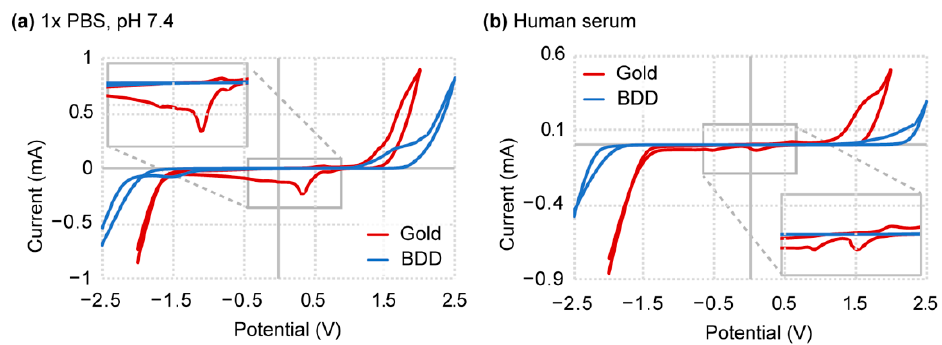
Figure 2. Cyclic voltammetry of boron-doped diamond (BDD) and gold electrodes in ( a ) 1× PBS and ( b ) human serum. Boron-doped diamond displayed extended solvent windows and reduced background in both fluids compared to gold.